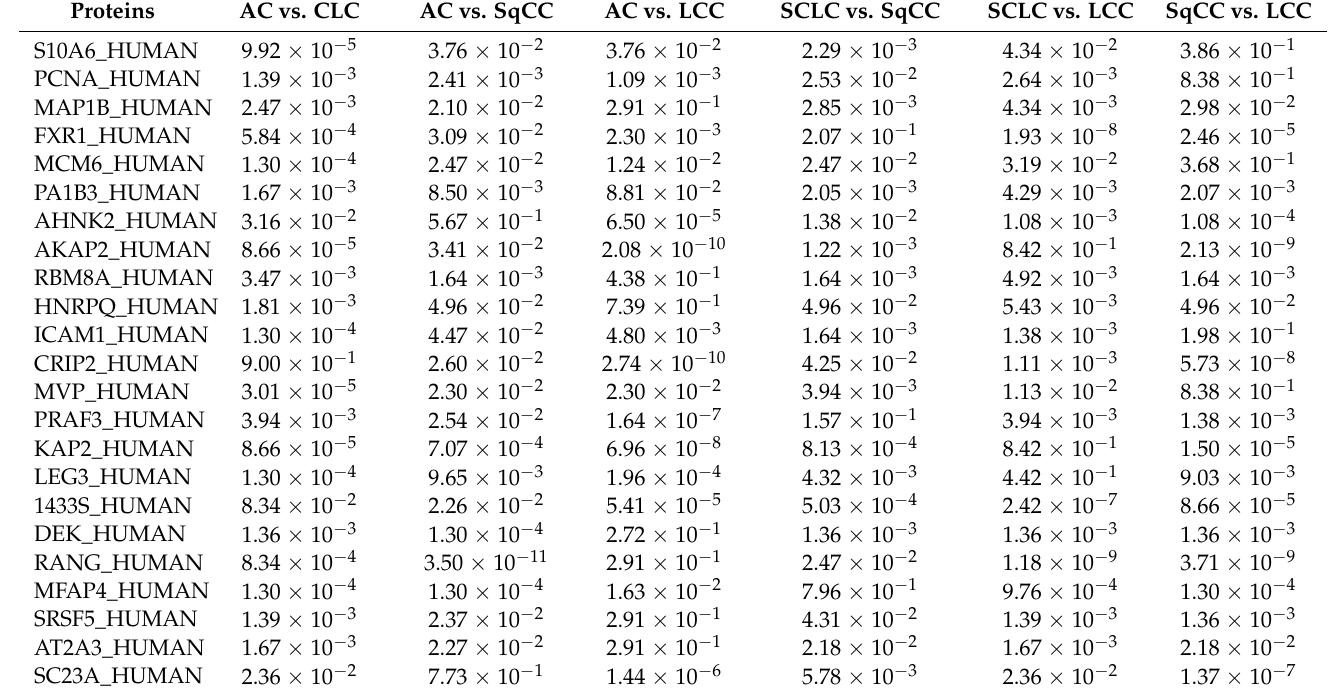
Table 3. List of the 23 proteins differentially expressed between 5 out of 6 comparisons with p